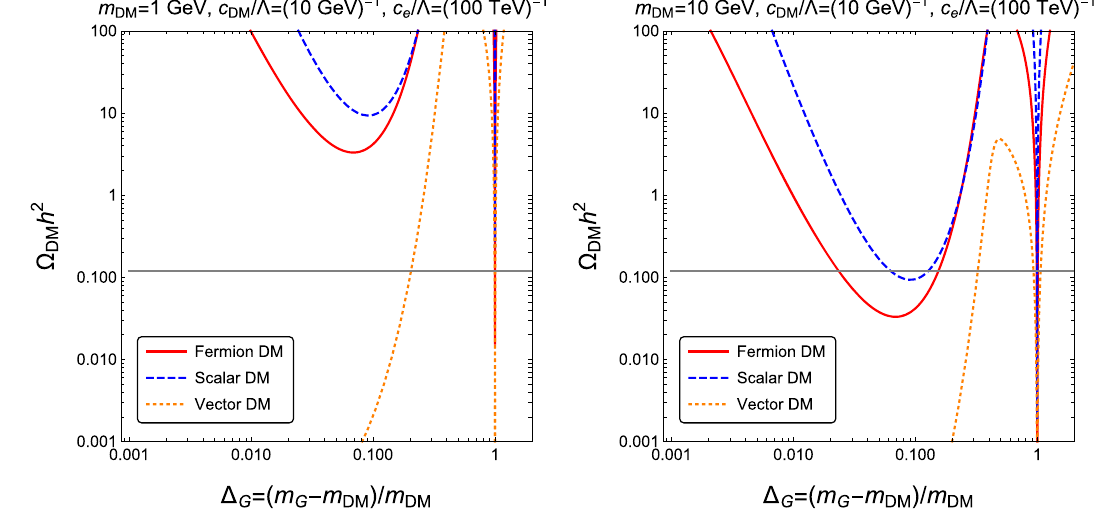
Fig. 7 The same as in Fig. 6, except for c e /(cid:3) = ( 100TeV ) − 1